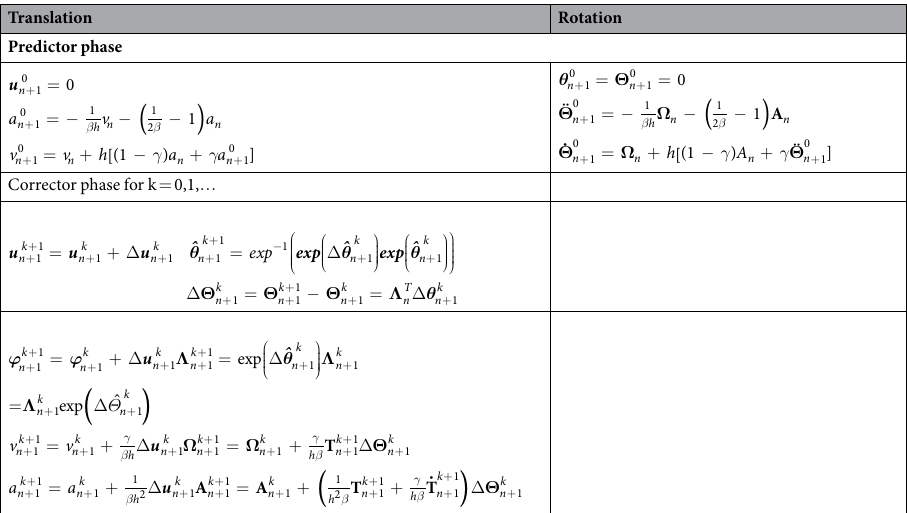
Table 4. Improved Newmark